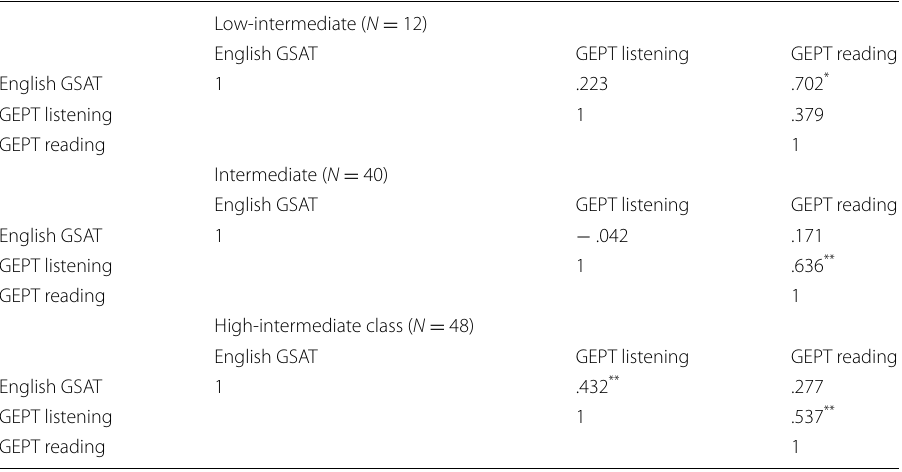
Table 8 Correlations among the English GSAT scores, the GEPT listening scores, the GEPT reading scores, and the final course grades across three